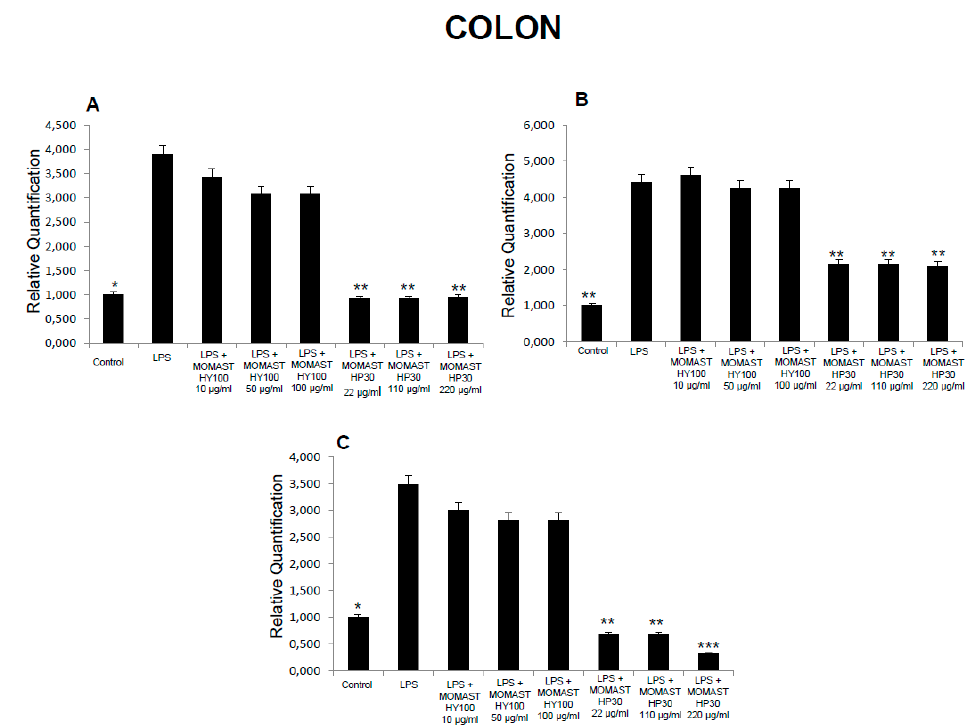
Figure 5. Effects of MOMAST( ® ) HY100 (10, 50, and 100 µg/mL) and MOMAST( ® ) HP30 (22, 110, and 220 µg/mL) on ( A ) cyclooxygenase (COX)-2, ( B ) tumor necrosis factor α (TNF α ), and ( C ) inducible nitric oxide synthase (iNOS) in rat prefrontal cortex specimens. Data were reported as means ± SEM. ANOVA, p < 0.01; post-hoc test, * p < 0.05, ** p < 0.01, *** p < 0.001 vs. LPS-treated group.